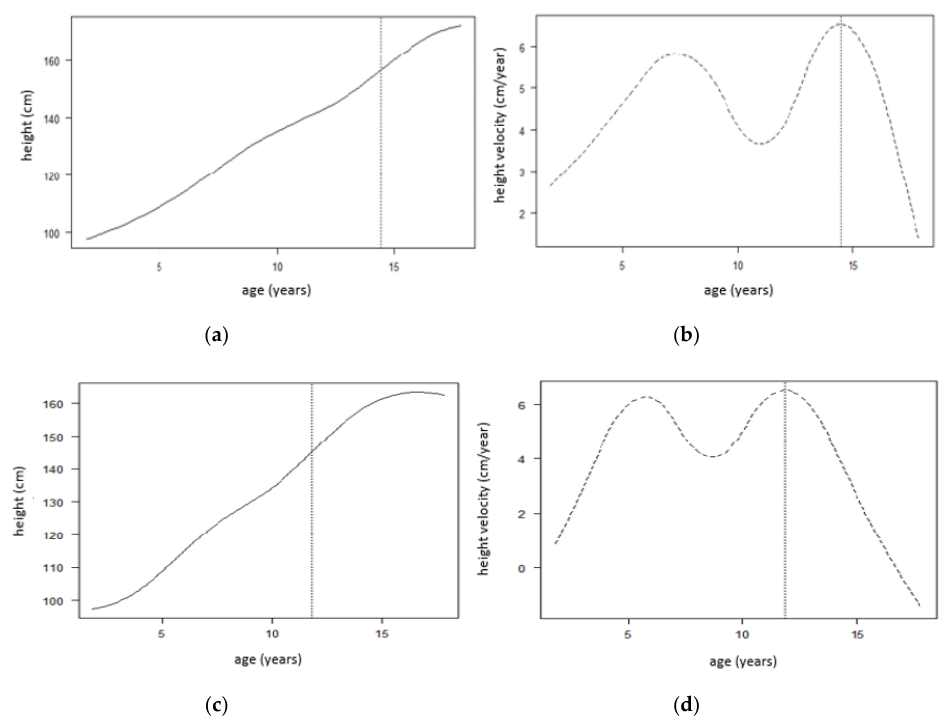
Figure 3. SITAR mean growth for boys and girls (separately). Mean curves, fitted by SITAR model, are illustrated for height growth ( a , c ) and height velocity ( b , d ) indicating mean at peak height velocity of 14.45 and 11.82 years ( a , c ) respectively, and mean peak height velocity of 6.54 and 6.52 cm / year ( b , c ) respectively. SITAR: Superimposition by Translation and Rotation.